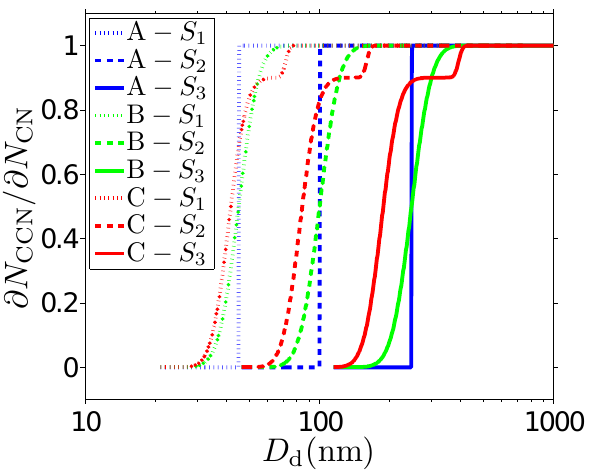
Fig. 3. CCN efficiency spectra (activation curves) of hypothetical model aerosols. Each line represents the spectrum of one type of mode aerosol (Case A, B, or C as specified in Table 1) obtained by D d scans at a fixed supersaturation S . The supersaturation levels are S 1 = 0.86%, S 2 = 0.26%, or S 3 = 0.067%.